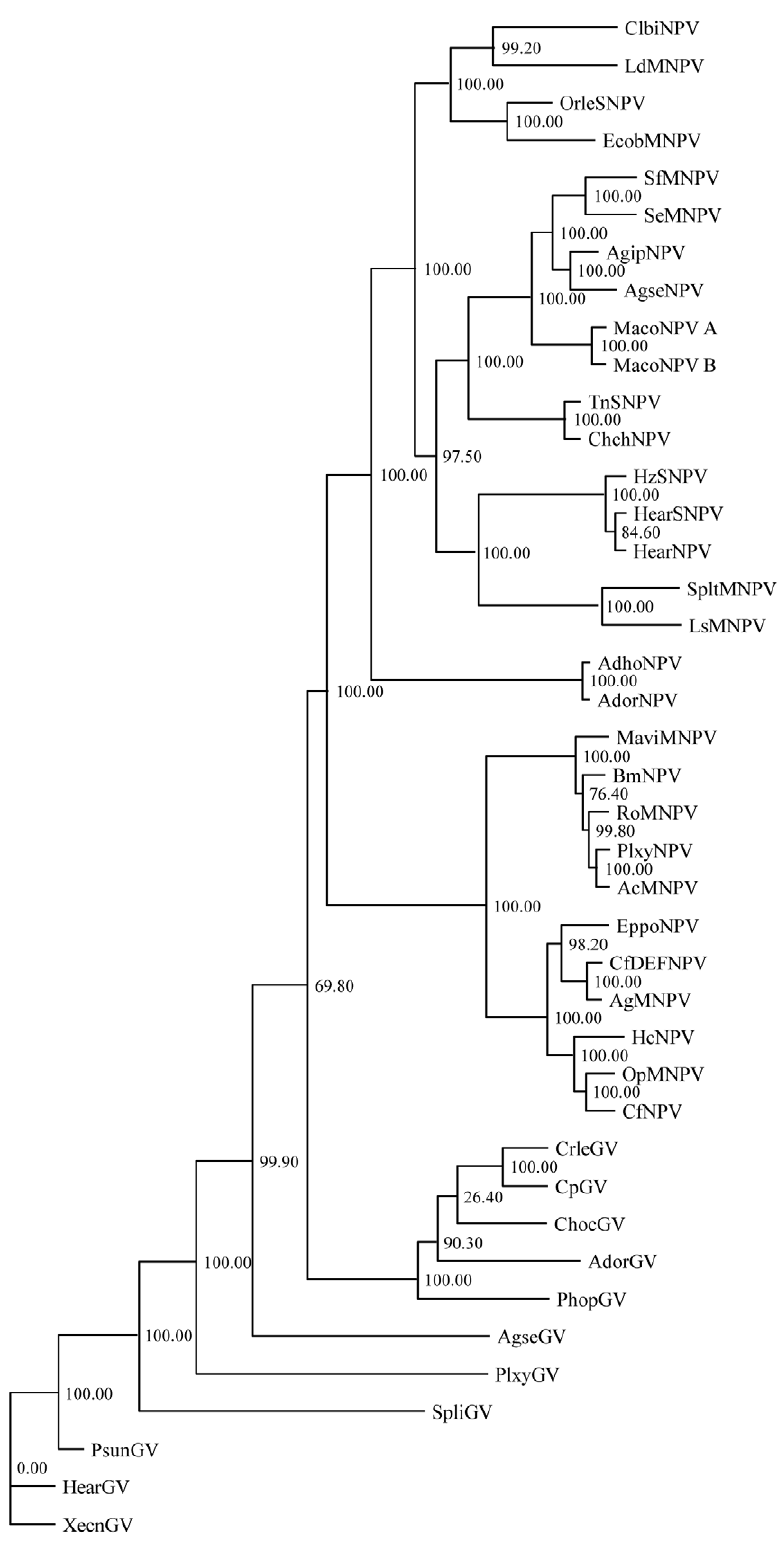
Figure 3. Phylogenic relationship between 41 complete baculovirus genomes based on the nucleotide sequences of 24 genes. The numbers on the branches represent bootstrap values for 1,000 replicates.